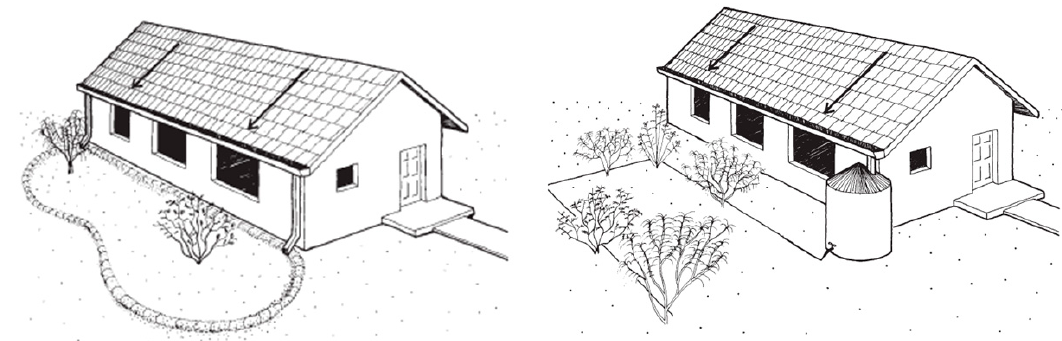
Figure 3. An illustration of ‘passive’ rainwater harvesting ( left ), in which rainwater is directly channeled to landscape areas, and ‘active’ systems ( right ) involving storage infrastructure such as a tank or cistern (adapted from [23]; reprinted with permission).